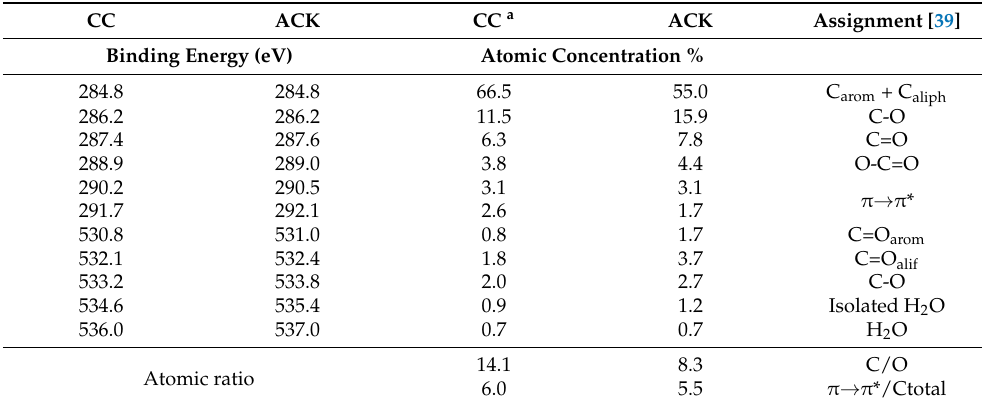
Table 4. Binding energy values (eV) for C 1s and O 1s fitted peaks, atomic concentrations %, and atomic